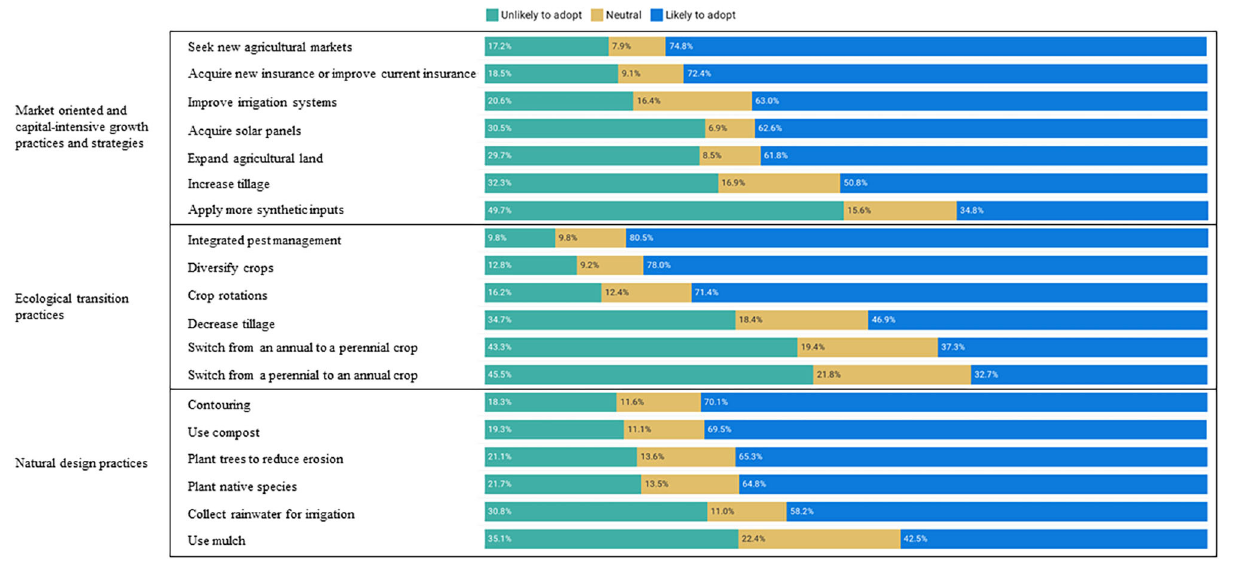
capital) were more linked to adoption, while larger farms were less likely to have adopted conservation